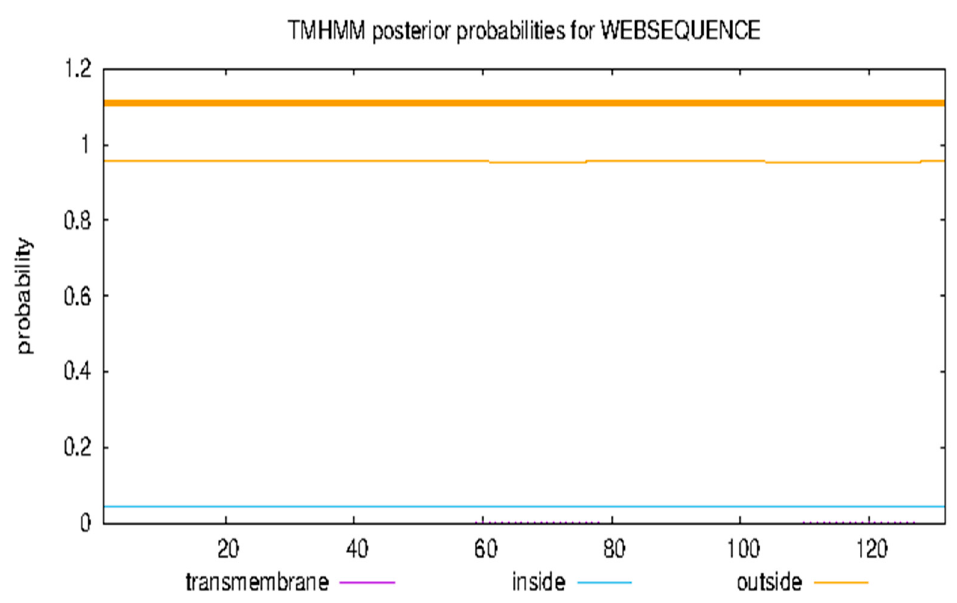
Figure 9. TransMembrane prediction using Hidden Markov Models (TMHMM) of TPD1-like pro- tein.